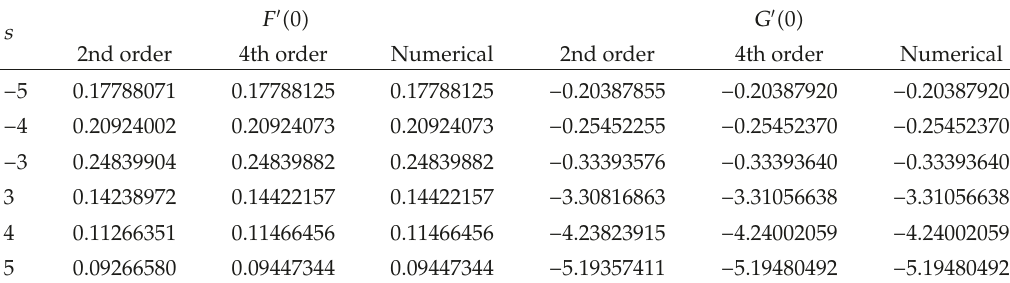
Table 5: Flow parameters F (cid:4) (cid:6) 0 (cid:7) and G (cid:4) (cid:6) 0 (cid:7) at di ff erent orders for the SLM approximations when L (cid:10) 20, N (cid:10) 120 for di ff erent s values when m (cid:10)